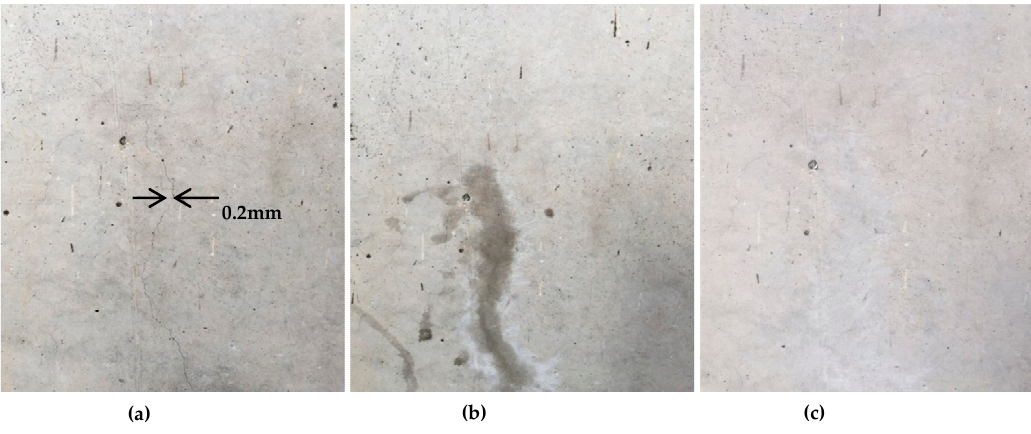
Figure 15. ( a ) Crack before repair; ( b ) crack after repair; and ( c ) crack after 60 days of repair.